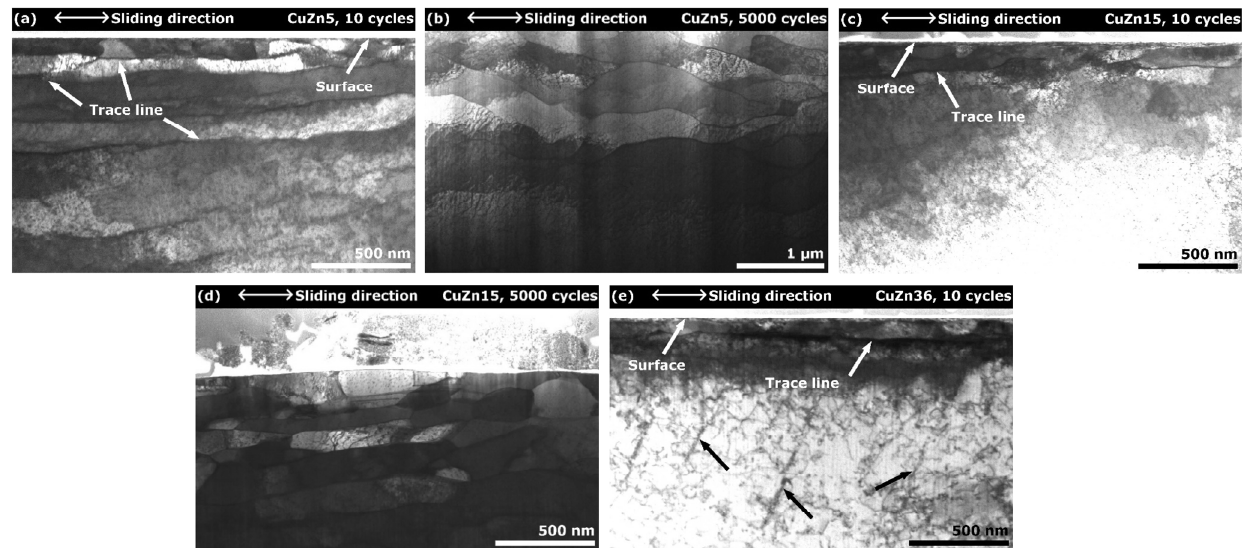
Fig. 9 Scanning transmission SEM images of the three brass alloys in early (10 cycles) and late (5,000 cycles) stages of tribological loading. (a) CuZn5 after 10 cycles; (b) CuZn5 after 5,000 cycles; (c) CuZn15 after 10 cycles; (d) CuZn15 after 5,000 cycles; (e) CuZn36 after 10 cycles. Slip bands are highlighted by black arrows; (f) CuZn36 after 5,000 cycles. The sample surfaces and the trace line are marked by white arrows. All TEM foils were prepared parallel to the sliding direction and perpendicular to the sliding surface (cross-sectional